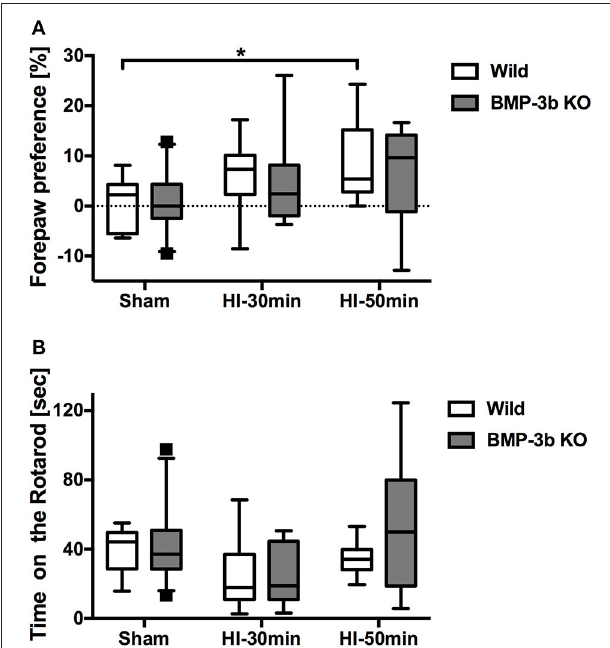
FIGURE 4 | (A) Hemiplegia, i.e., disuse of the affected right forepaw, was evaluated in cylinder tests 7 days after surgery (i.e., postnatal day 19, P19). The number of forepaw contacts made with the wall during rearing were counted. Paw preference was calculated as follows: (left [non-impaired side]—right [impaired side])/(left + right) × 100%. (B) Sensorimotor skills were evaluated in rotarod tests 8 days after surgery (P20). The average time until the animal fell off the rotating drum in 5 consecutive sessions was analyzed. The box shown extends from the 25 to 75th percentiles. The whiskers shown are drawn down to the 5th and up to the 95th percentile. Points below and above the whiskers are drawn as individual dots. The no-surgery controls were combined with the sham group because there was no difference in performance between these groups. In the cylinder test, Wild Sham, n = 12; Wild HI-30min, n = 16; Wild HI-50min, n = 8; BMP-3b KO Sham, n = 22; BMP-3b KO HI-30min, n = 12; and BMP-3b KO HI-50min, n = 17. In the rotarod test, Wild Sham, n = 7; Wild HI-30min, n = 10; Wild HI-50min, n = 10; BMP-3b KO Sham, n = 25; BMP-3b KO HI-30min, n = 12; and BMP-3b KO HI-50min, n = 9. * p <